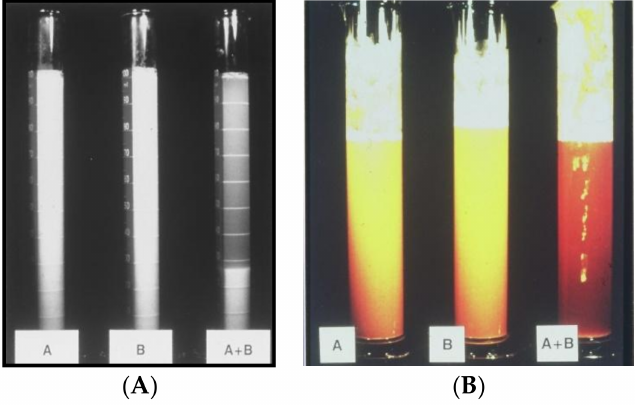
Figure 6. ( A ) Helm’s sedimentation flocculation test—co-flocculation [28,29]; ( B ) ale yeast co-flocculation—2-L cylinder wort fermentation test